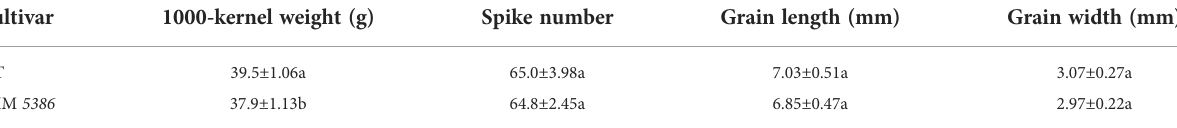
TABLE 2 Yield components of WT and LMM 5386 lines. Cultivar